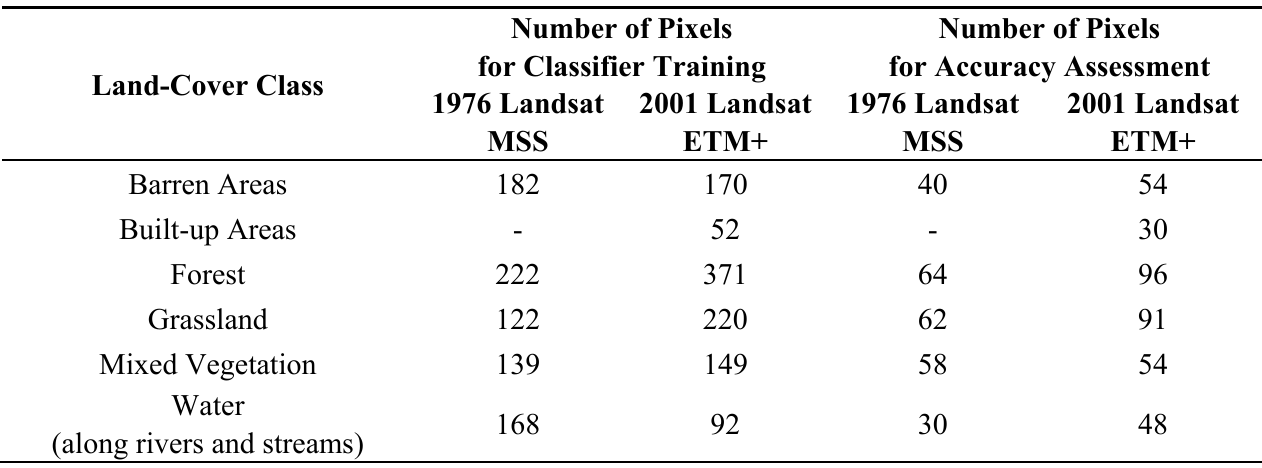
Table 1. Land-cover classes identified from the Landsat MSS and ETM+ images of the study area with number of samples collected for classifier training and accuracy